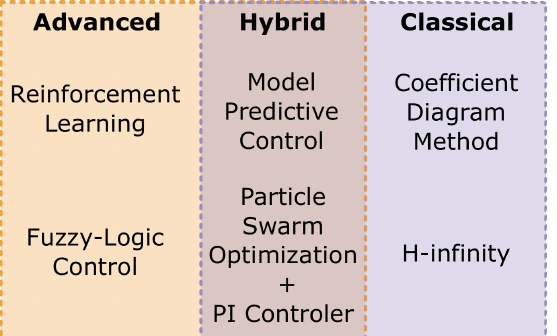
Figure 4. Classification of algorithms for virtual inertia control. PI—proportional